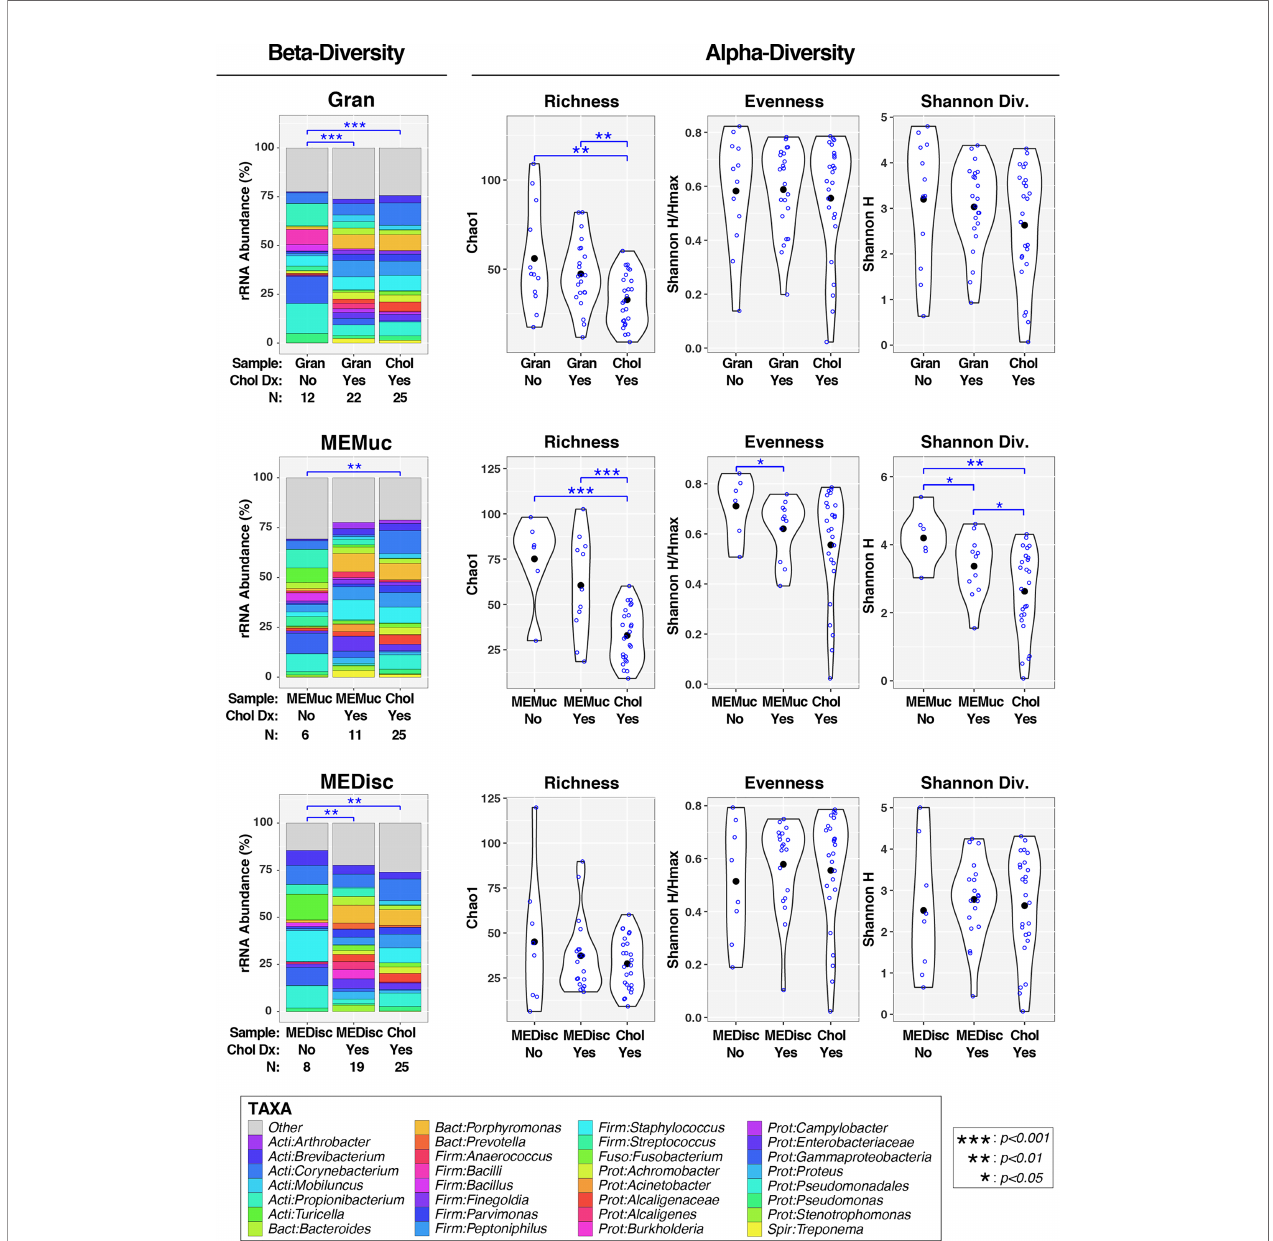
FIGURE 3 | Association of cholesteatoma diagnosis with middle ear microbiota. Each panel compares microbiota for either Gran, MEMuc, or MEDisc samples between patients without and with cholesteatoma diagnosis; for comparison, each panel includes Chol samples from patients with cholesteatoma. The left column (under the heading “ Beta-Diversity ” ) displays barcharts summarizing the mean relative abundances of predominant taxa (>2%RA) in each comparison group; rarer taxa are grouped into the “ Other ” category. Results of PERMANOVA tests (adjusted for age and quinolone use) are indicated above barcharts. Blue lines/symbols indicate FDR-corrected p-values for pairwise comparisons. The right columns (under the heading “ Alpha-Diversity ” ) display violin plots for each comparison group. Open blue circles indicate individual samples while fi lled black circles designate group means. Results of linear mixed-effects tests (adjusted for age and quinolone use) are indicated above violin plots. Blue lines/symbols indicate p-values for pairwise comparisons with false discovery rate